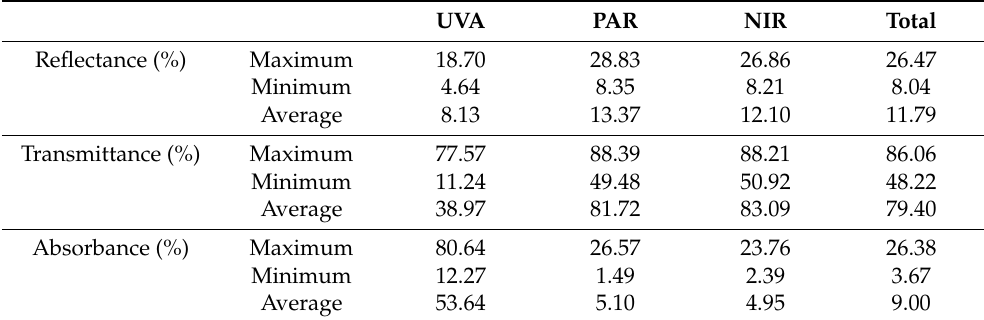
Table 2. Values (in %) of maximum, minimum and average of reflectance, transmittance and ab- sorbance of the studied polymeric